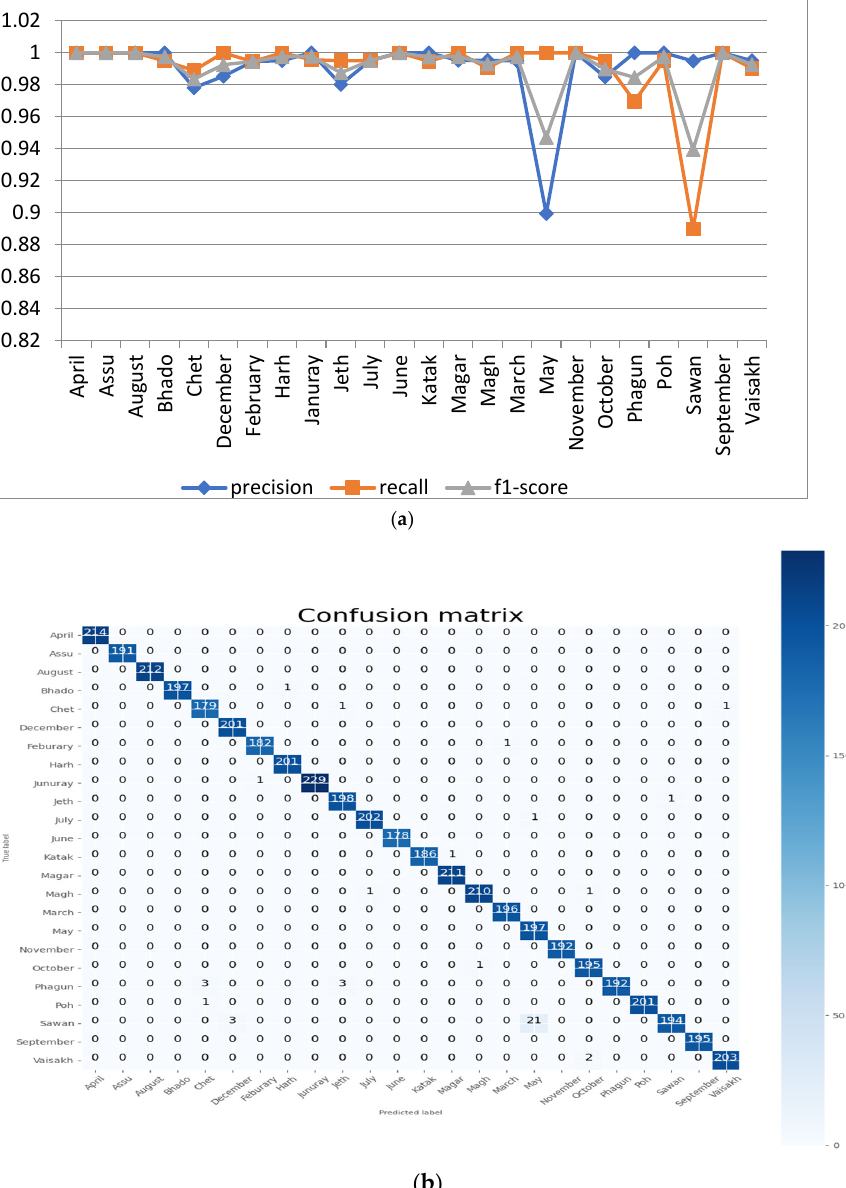
( c ) Figure 7. Analysis of proposed model at 100 epochs and a batch size of 30: ( a ) precision, recall, and F1 score for the 24 classes; ( b ) confusion matrix; ( c ) accuracy and loss curve. 5.1.3. Analysis with Batch Size 40 For this experiment, the proposed CNN model was run at 100 epochs with a batch size of 40 batch size. The resulting performance analyses of the proposed model are shown in Figure 8a. It can be seen from the figure that the value of precision is 1 for the month names ‘April’, ‘Assu’, ‘Bhado’, ‘February’ ‘July’, ‘June’, ‘Katak’, ‘November’ and